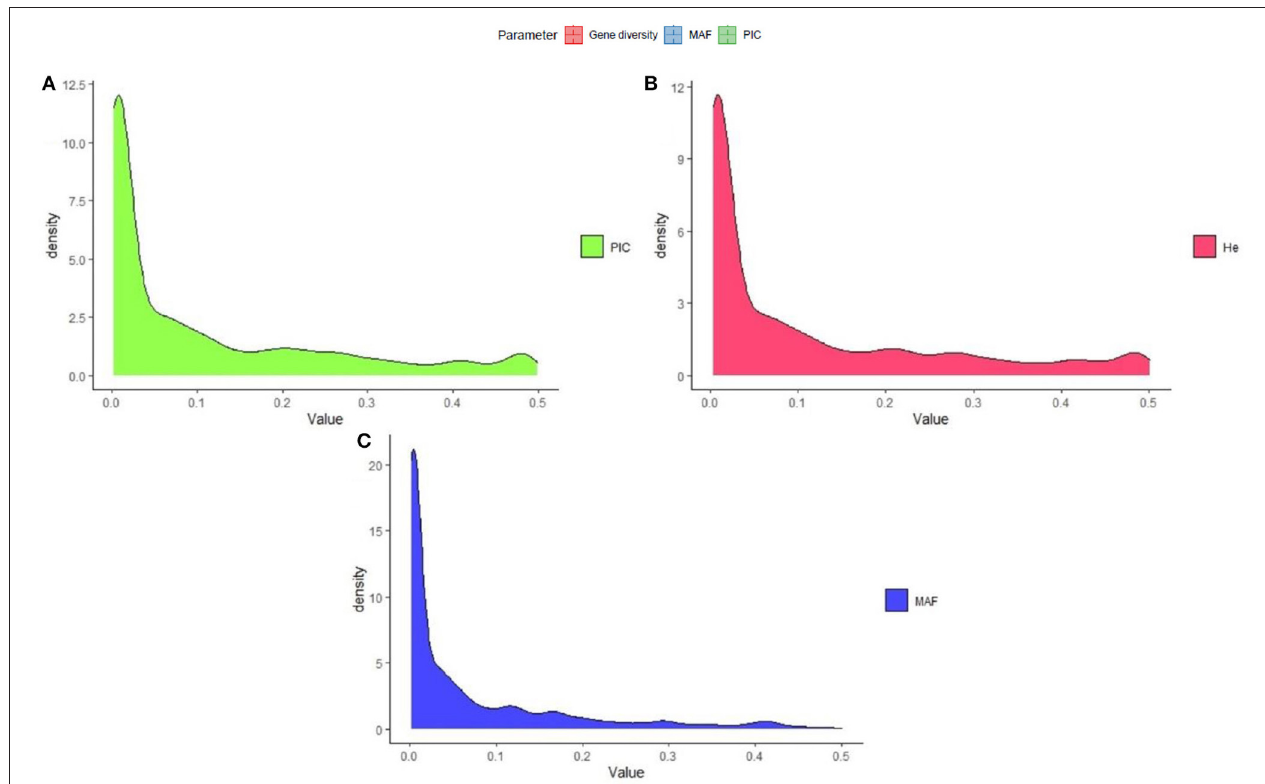
FIGURE 2 | Frequency distribution of quality marker parameters of (A) polymorphism information content (PIC), (B) gene diversity (He), and (C) minor allele frequency (MAF) for DArTseq markers in the finger millet diversity panel.